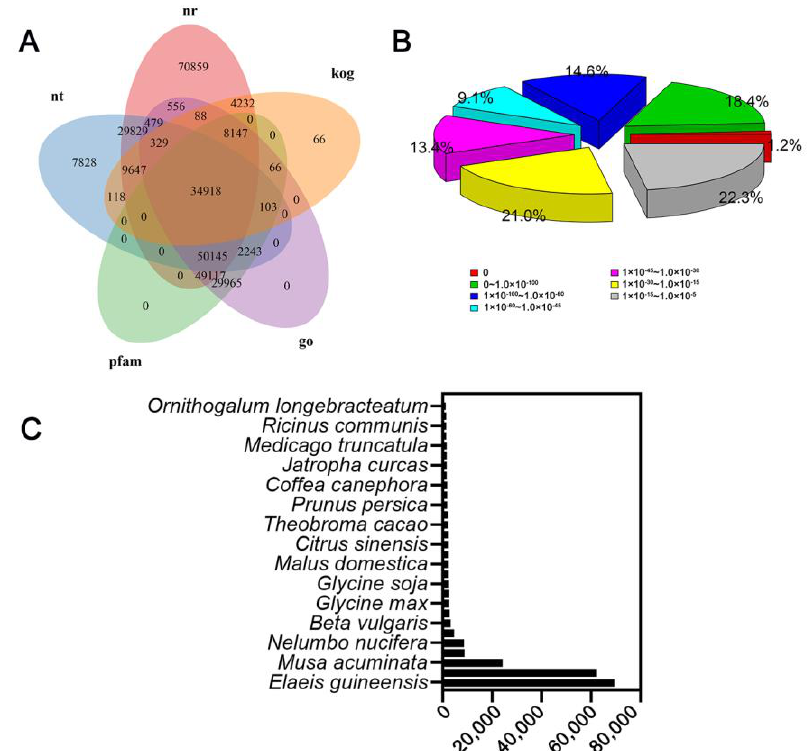
Figure 2. Homology search characteristics of P. odoratum unigenes. ( A ) A Venn diagram showing the number of unigenes annotated by BLASTx. A circle indicates the number of unigenes annotated by single or multiple databases. ( B ) E-value distribution of the top BLASTx hits against the Nr database. ( C ) The number of unigenes in Nr database that match the 30 top species using BLASTx. In root tissues of P. odoratum , 15,788 DEGs were screened out, including 4843 upreg- ulated DEGs and 10,945 downregulated DEGs (pa dj < 0.05, and the |log2ratio| ≥ 1; Figure